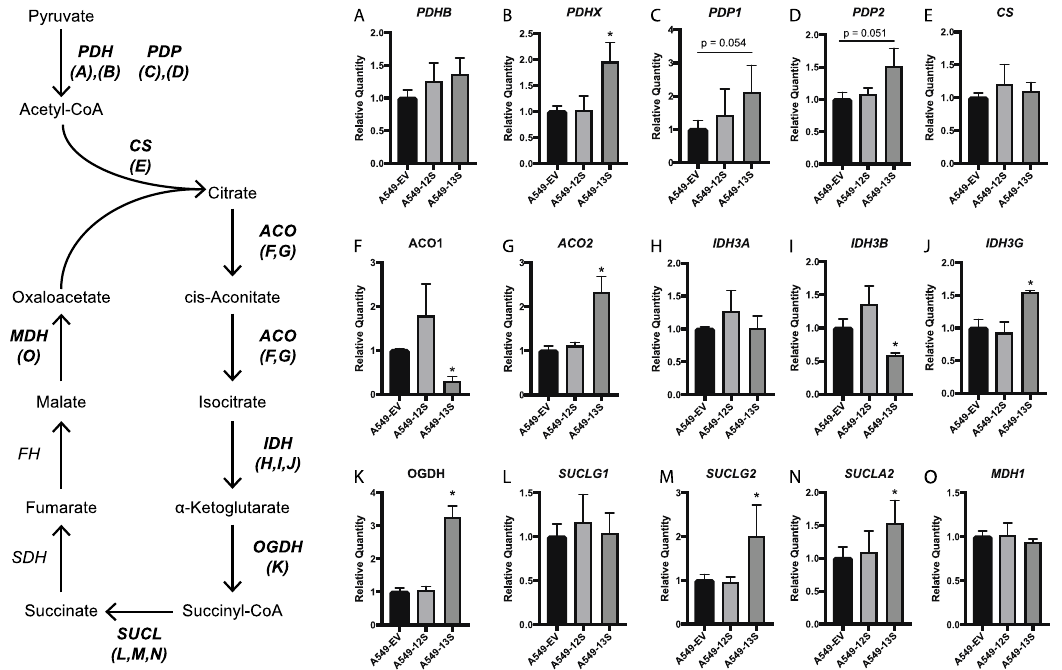
Figure 4. Relative expression of mRNA for tricarboxylic acid cycle genes in 13S and 12S expressing A549 cells. ( A – O ) The mRNA expression for 15 genes encoding components of the tricarboxylic acid (TCA) cycle were measured with qPCR. A549-13S cells displayed upregulated mRNA levels of enzymes involved in the TCA cycle. A549-13S cells had statistically significant upregulation of transcripts encoding six enzymes involved in the TCA cycle ( B , G , J , K , M , N ) and downregulation of two TCA cycle enzyme encoding transcripts ( F , I ). In contrast, A549-12S cells did not exhibit any statistically significant differences in TCA cycle transcript expression compared to the A549-EV cells. The geometric mean of two reference genes, H2AFY and ACTB was used. Asterisks (*) indicate p < 0.05. n = three per group for all panels. PDH , pyruvate dehydrogenase; PDP , Pyruvate dehydrogenase phosphatase; CS , Citrate synthase; ACO , Aconitase; IDH , Isocitrate dehydrogenase; OGDH , Oxoglutarate dehydrogenase; SUCLG1 , Succinate-CoA ligase GDP / ADP-forming subunit alpha; SUCLG2 , Succinate-CoA ligase GDP-forming subunit beta; SDH , Succinate dehydrogenase; FH , Fumarate hydratase; MDH , Malate dehydrogenase.